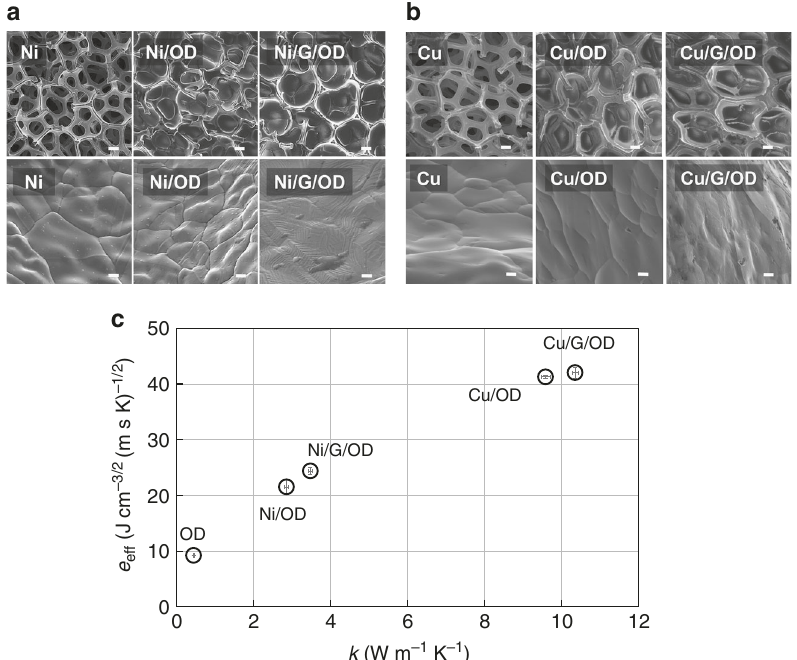
Fig. 1 Fabrication and characterization of ultra-high thermal effusivity materials. a SEMs for pristine Ni foam (Ni), Ni foam impregnated with OD (Ni/OD), and Ni/G/OD (left to right). Scale bars: top row (100 μ m), bottom row (1 μ m). b SEMs for pristine Cu foam (Cu), Cu foam impregnated with OD (Cu/OD), and Cu/G/OD (left to right). Scale bars: top row (100 μ m), bottom row (1 μ m). c Scatter plot showing the enhancement in effective thermal effusivity for our ultra-high thermal effusivity materials compared with a standard PCM (OD) and its metal foam composites as a function of the thermal conductivity of the composite. Error bars represent 95% con fi dence intervals